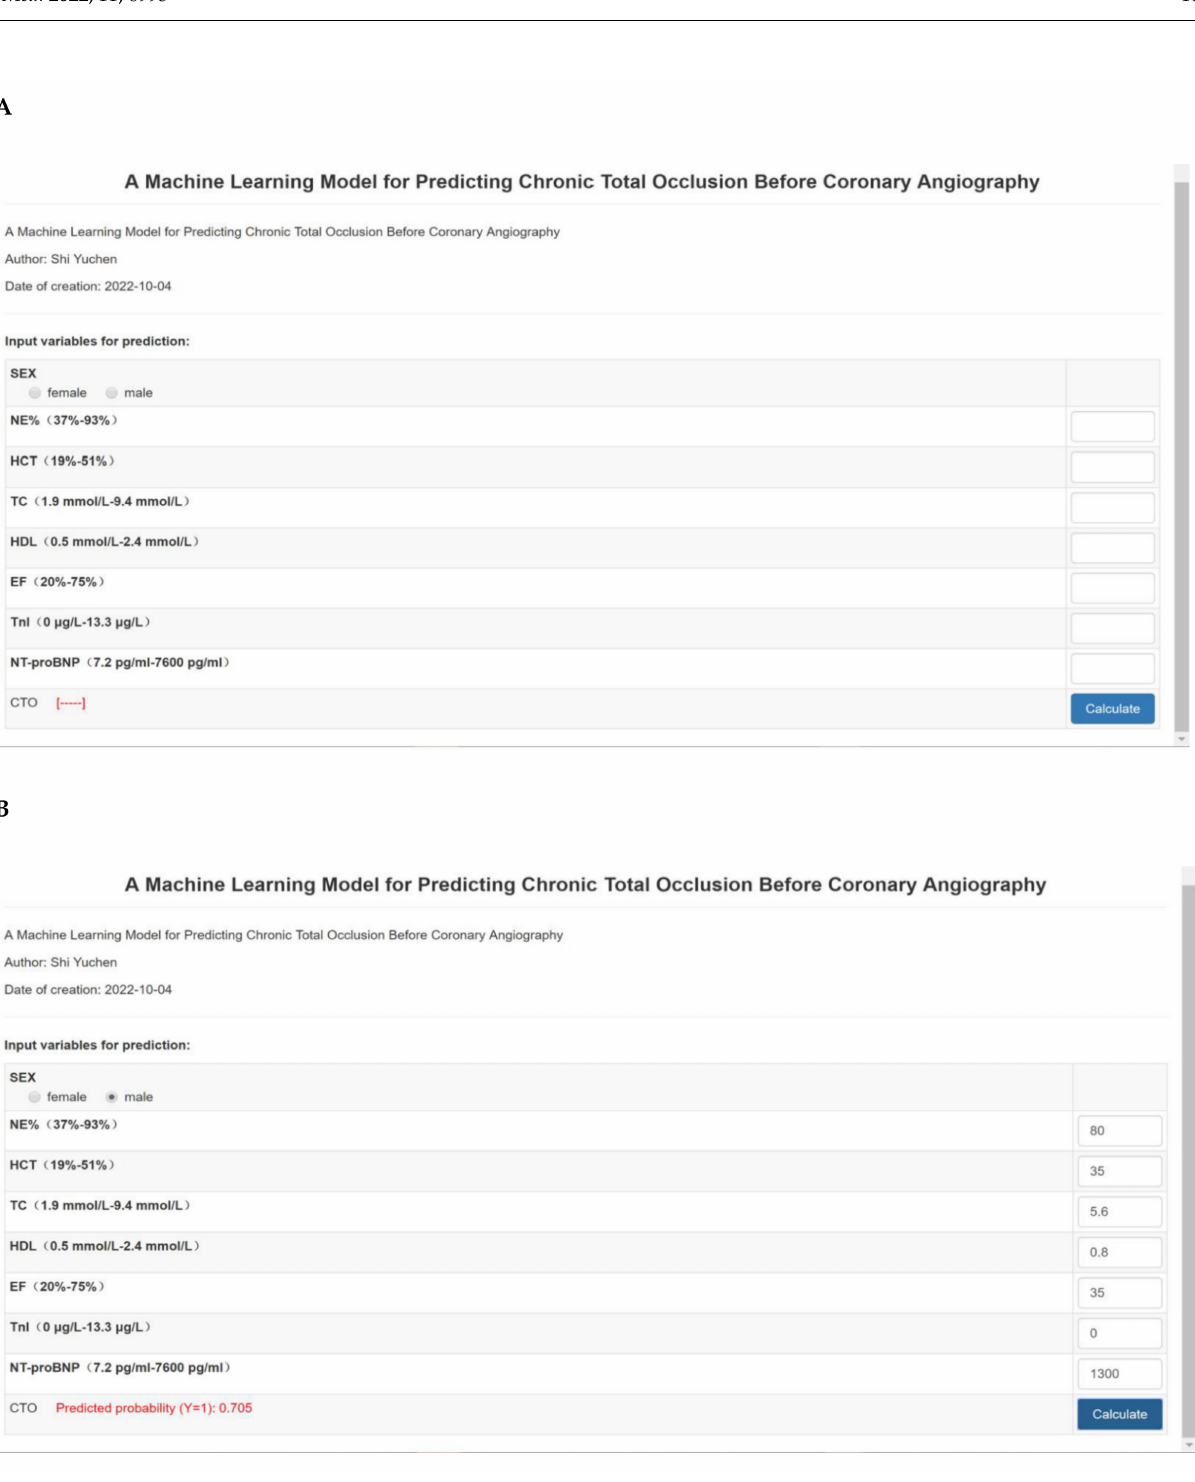
Figure 3. The URLs of the web calculators for our model are as follows: http://www.empowerstats. net/pmodel/?m=29484_CTOBeforeCAG, accessed on 4 October 2022. ( A ) is the flame of the model. ( B ) is an example that if the patient is male with NE% of 80%, HCT of 35%, TC of 5.6 mmol/L, HDL of 0.8 mmol/L, EF of 35%, TnI of 0 µ g/L, and NT-proBNP of 1300 pg/mL, the probability of CTO might be